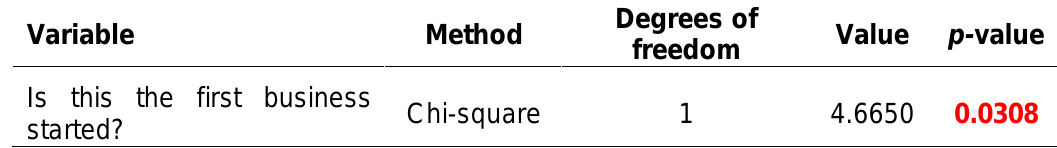
Table 6: Significant Differences Relating to Number of Business